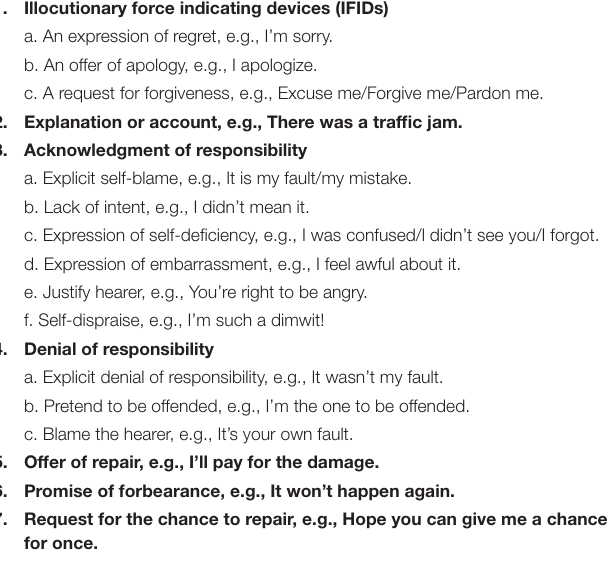
TABLE 1 | Coding scheme for apology strategy.